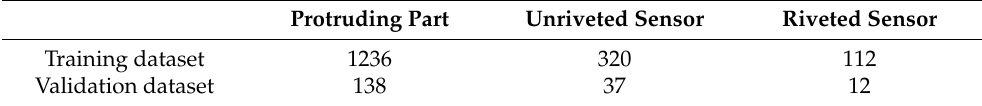
Table 1. The number of objects to